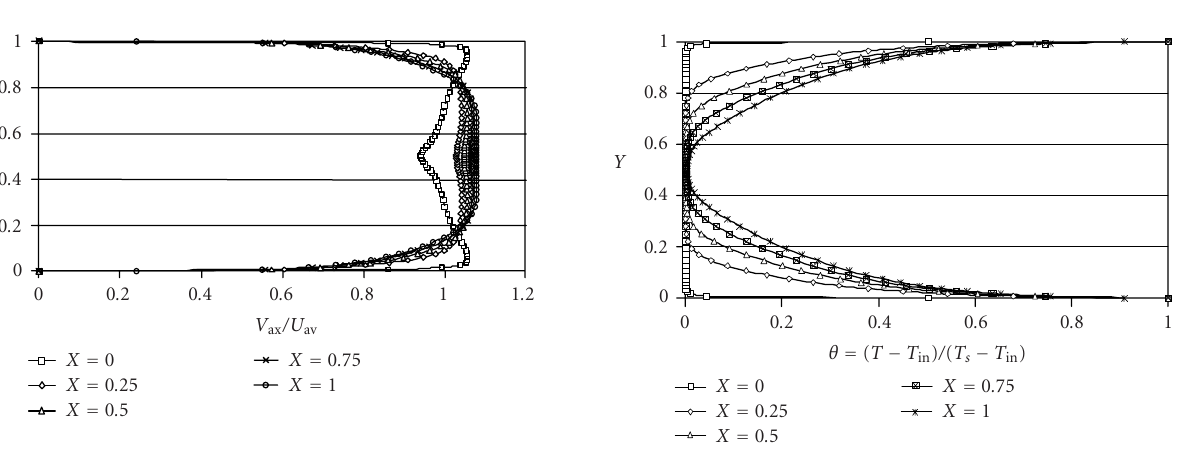
Figure 5: Axial velocity profiles at di ff erent sections of the cooling channel for Re = 50000 and ˙ m r = 1 / 1.